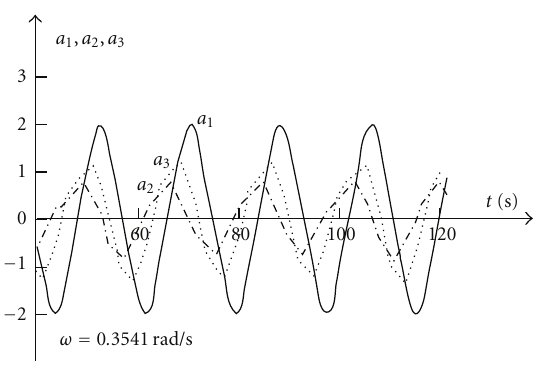
Figure 16: Time responses of Example